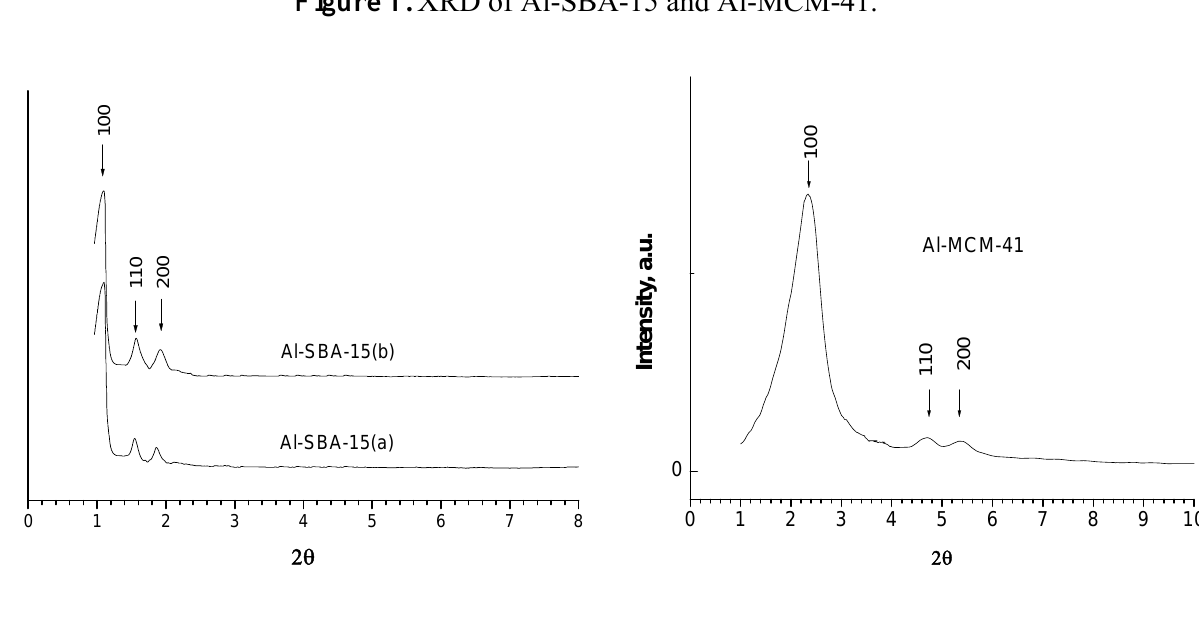
Figure 1. XRD of Al-SBA-15 and